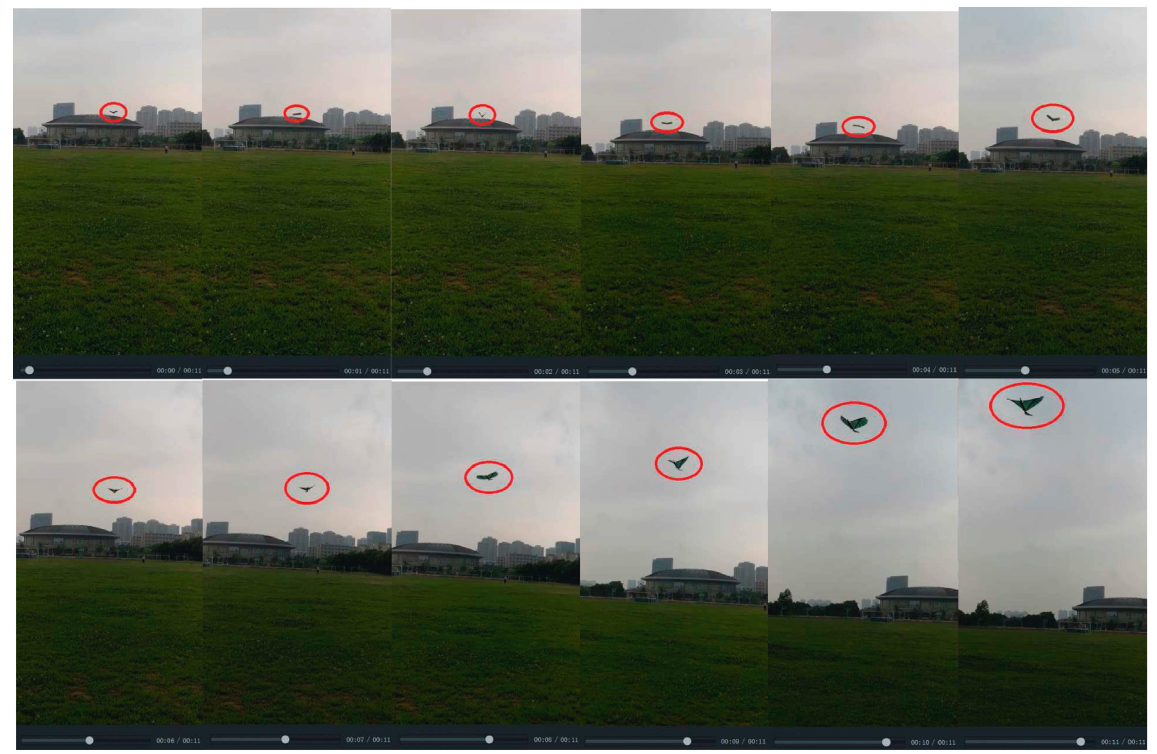
Figure 12: Prototype experiments of the